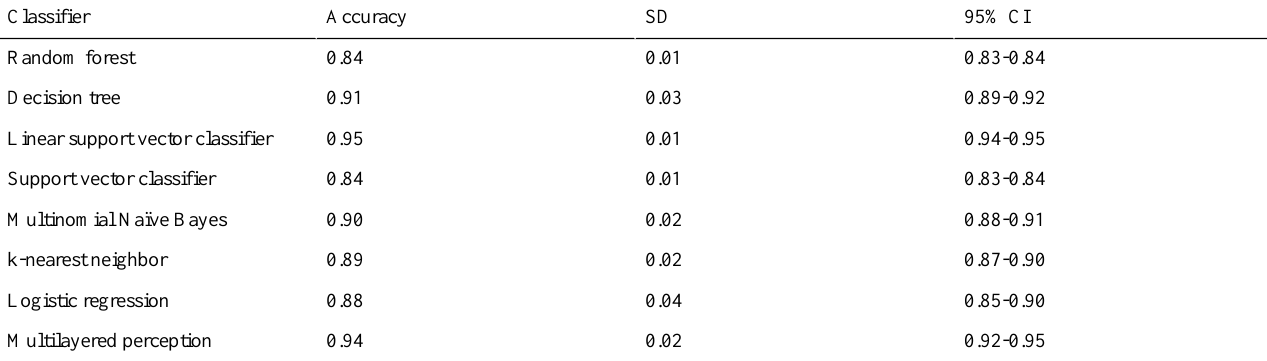
Table 1. Machine learning classifier n-fold cross-validation accuracy, SD, and 95% CI based on the gold standard training dataset of 4470